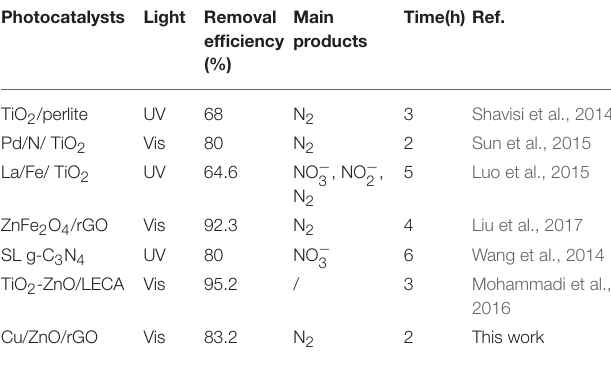
TABLE 1 | Comparison of ammonia removal efficiency (%) using various photocatalysts. Photocatalysts Light Removal